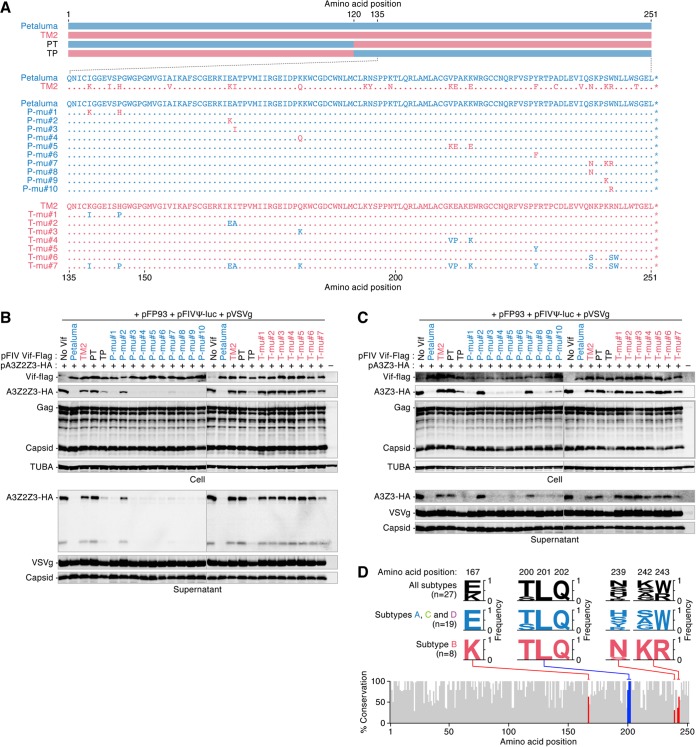
The responsive residue determines the ability of FIV Vif to degrade feline A3. (A) Schematic depicting the FIV Vif derivatives used. (B and C) Expression plasmids for a series of FIV Vif derivatives tagged with Flag were cotransfected with or without the expression plasmids for feline A3Z2Z3 (B) or A3Z3 (C) tagged with HA. Representative results of Western blotting assays are shown. (D) VESPA analysis. The percent amino acid sequence conservation was analyzed using VESPA (http://www.hiv.lanl.gov/content/sequence/VESPA/vespa.html) (34). The accession numbers of the FIV Vif sequences (subtype A, n = 5; subtype B, n = 8; subtype C, n = 10; subtype D, n = 4) are listed in Table 1. In the bottom panel, residues 167 and 242 to 243 are indicated in red, while the (T/S)LQ motif (residues 200 to 202) is indicated in blue. In the top panel, the amino acids in these positions are indicated as logo plots. n, the number of sequences used.